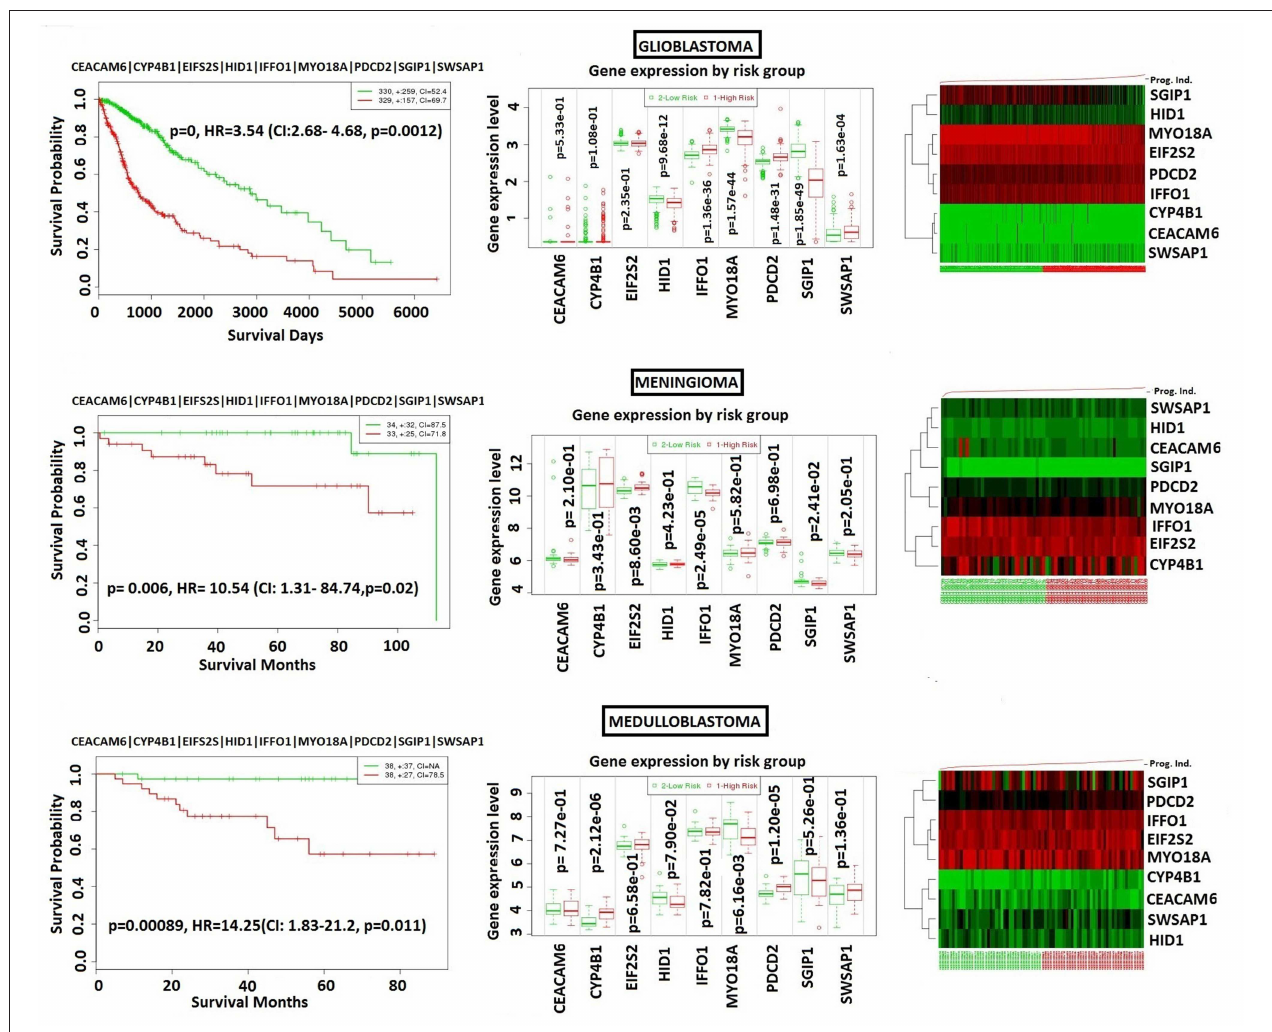
FIGURE 9 | Prognostic power of core module through 3 types of brain tumors. (A) glioblastoma, (B) meningioma, (C) medulloblastoma.